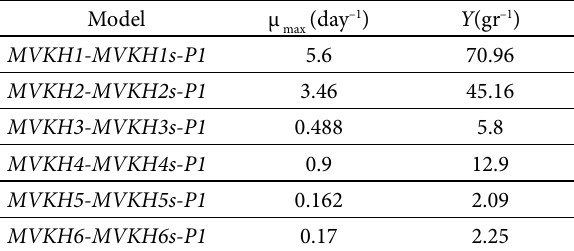
Table 5. The values of μ and Y calculated by nonlinear max regression in each six various combinations of the first simulation